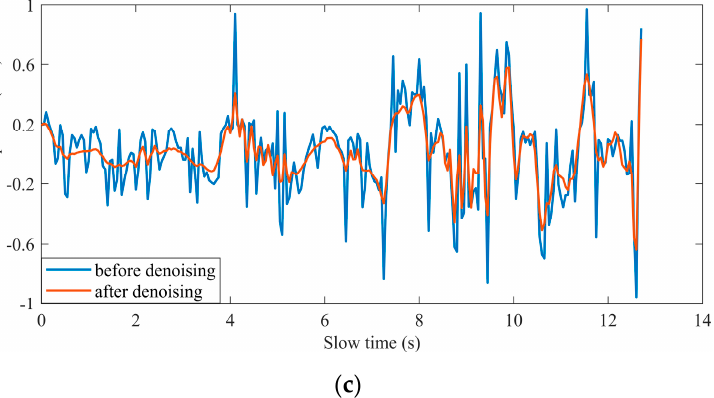
Figure 7. The impulse noise removal: ( a ) in the time domain; ( b ) in the frequency domain; ( c ) waveform comparison before and after denoising.